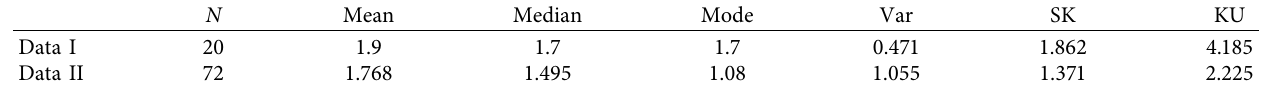
Table 6: Descriptive statistics for the both datasets.